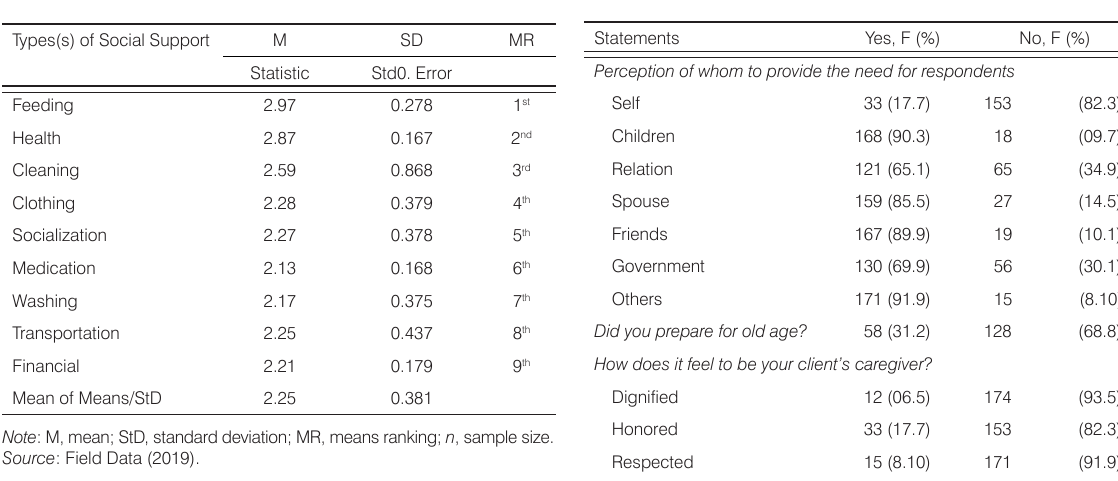
Table 2. Descriptive analysis of the types(s) of social support available for the respondents ( n = 186).